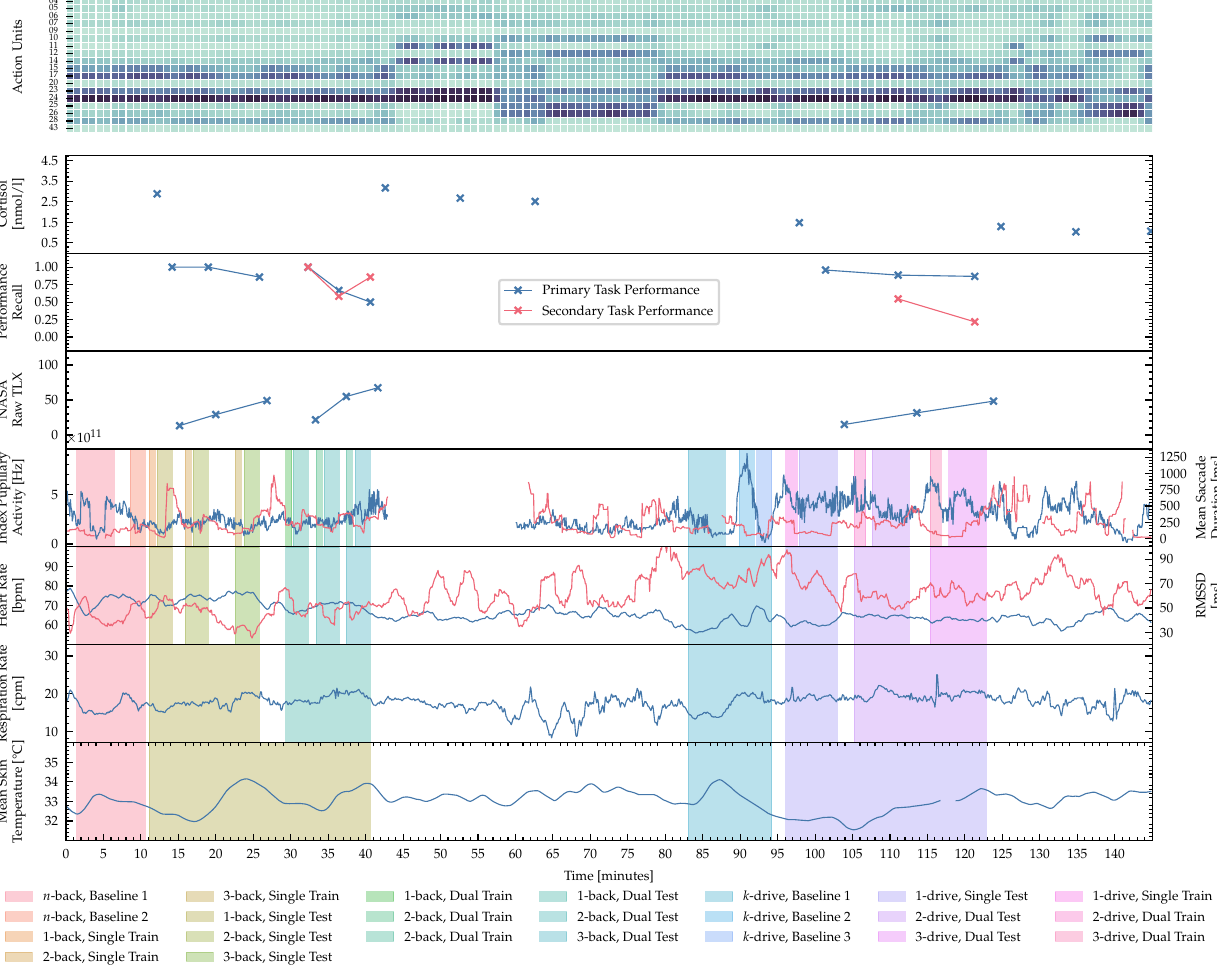
Figure 8. Visualization of the complete recording session for a single subject. Starting at the top-row: Continuously computed action units sampled with 25 fps, that are summed over 1-minute intervals and visualized as colors by occurrence (darker colors show higher activation). Followed by cortisol measurements, performance ratings and subjective feedback as NASA-RTLX scores. The last four rows visualize computed features with a rolling window of 2 min and step-size of 5 s, from eye- tracker, ECG (blue: HR , red: RMSSD ), respiration and skin temperature measurements. Aligned with the overall time axis the different phases are presented as background colors. As described in Sections 2.2–2.4 the experiments ( n -back and k -drive) are in randomized order. In this example, the n -back test was conducted first, followed by the questionnaire phase, and the driving phase. The n -back protocol was conducted as described in Figures 6 and 7: Single task n -back first in three levels, followed by dual-task n -back in three levels with training and testing phase. This subject did not repeat any training. If obvious measurement artifacts occurred during acquisition, the corresponding features were removed for downstream evaluations. This example shows corruption in the features of the eye tracker, as the subject’s head moved outside the recording region of our eye tracker during the phase between n -back and k